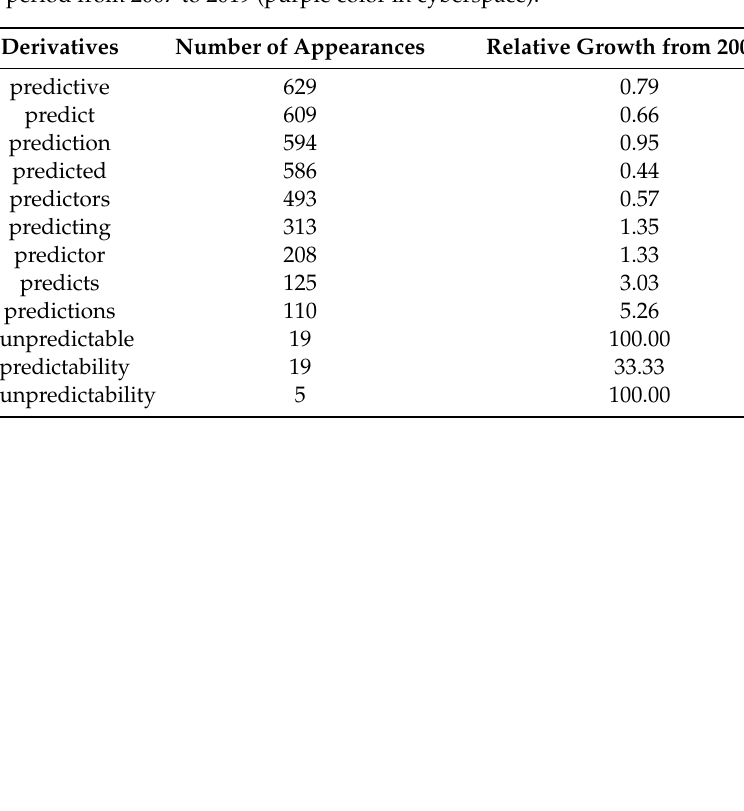
Table 1. Statistical results for derivatives with “predict” as the root word, extracted from the PubMed database for the period from 2007 to 2019 (purple color in